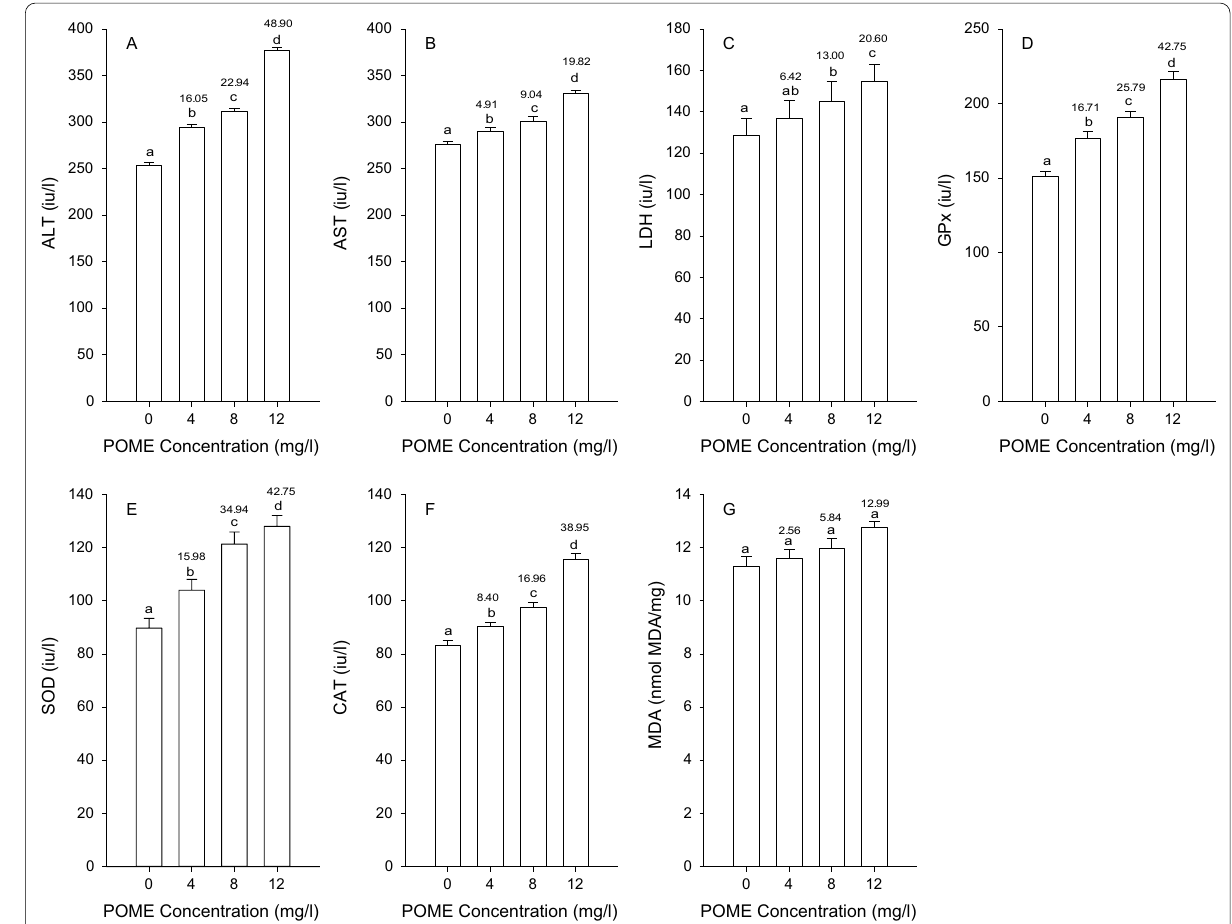
Fig. 3 Biochemical changes in the liver of Heteroclarias exposed to different concentrations of POME for 28 days. a ALT (alanine transaminase), b AST (aspartate transaminase), c LDH (lactate dehydrogenase), d GPx (glutathione peroxidase), e SOD (superoxide dismutase), f CAT (catalase), g MDA (malondialdehyde)